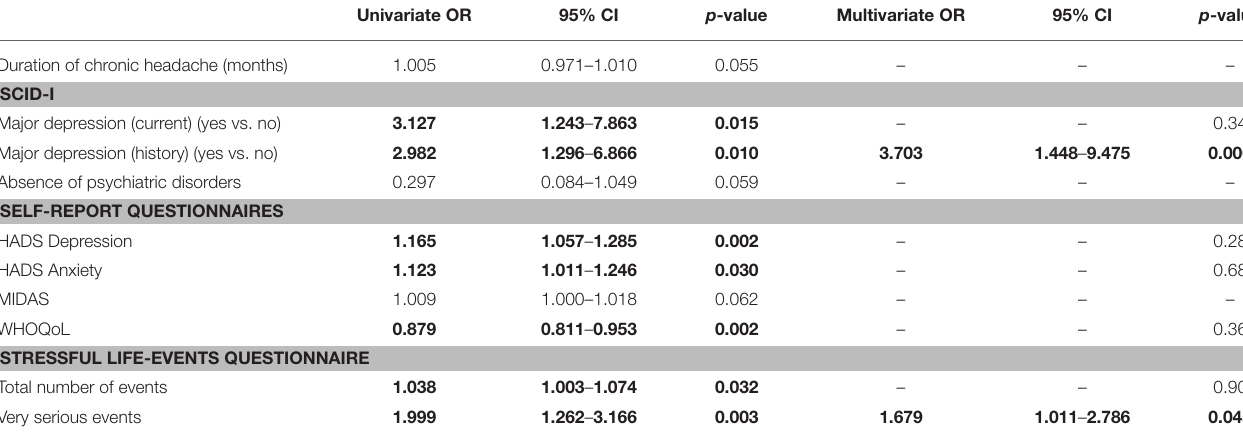
TABLE 4 | Model fit of logistic regression equations to predict persistence of chronic headache two months after l detoxification in the subjects who stopped